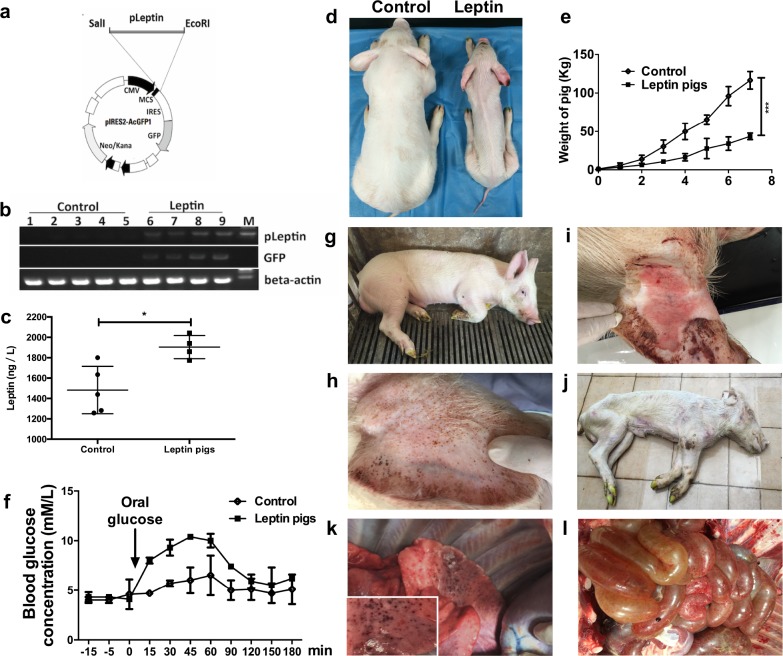
The strategy for generating transgenic leptin pigs.(a) Vector construction strategy. (b) Semiquantitative PCR results to separate leptin and control pigs. M, DNA ladder. (c) Serum leptin levels (n = 5 per group). (d,e) Appearances and differences in body weight in leptin and control pigs (n = 6 per group). (f) OGTTs reflect compromised glucose homeostasis in transgenic leptin pigs (n = 6 per group). (g–j) Disease development from 6 months to 8 months of age. Pigs died at 8 months old. (k–l) Anatomy of the transgenic leptin pigs when they died. *p < 0.05, ***p < 0.001, two-tailed Student t test for c, one-way analysis of variance for f and e. Data are presented as mean ± SEM. Numerical values are provided in S1 Data. CMV, cytomegalovirus; GFP, green fluorescent protein; IRES, internal ribosome entry sites; MCS, multiple cloning site; OGTT, oral glucose tolerance test.